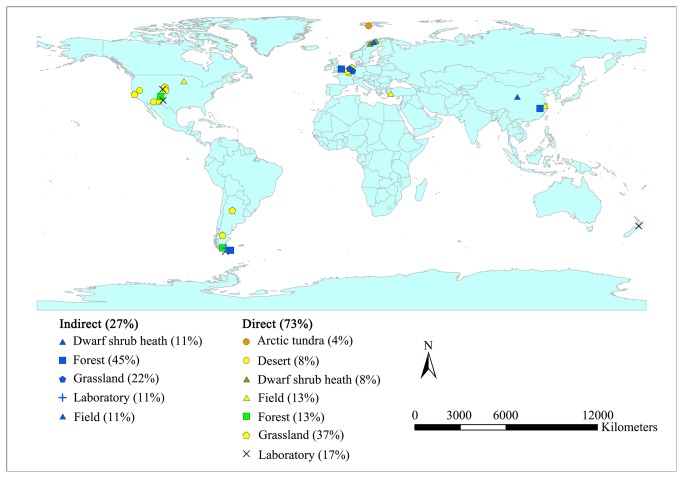
Global distribution of UV-B exposure studies included in meta-analysis.The percental proportion of each major landform type is provided in parenthesis.